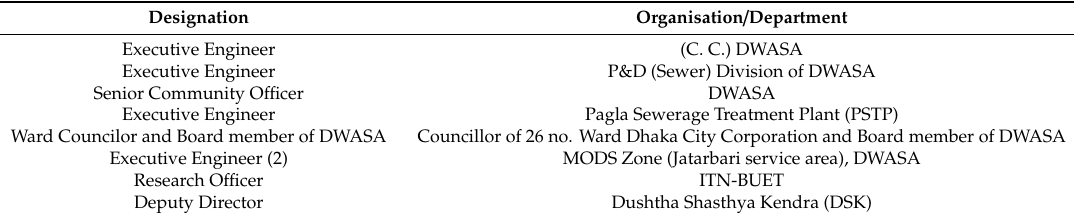
Table 1. Key informant interviews with the government and community